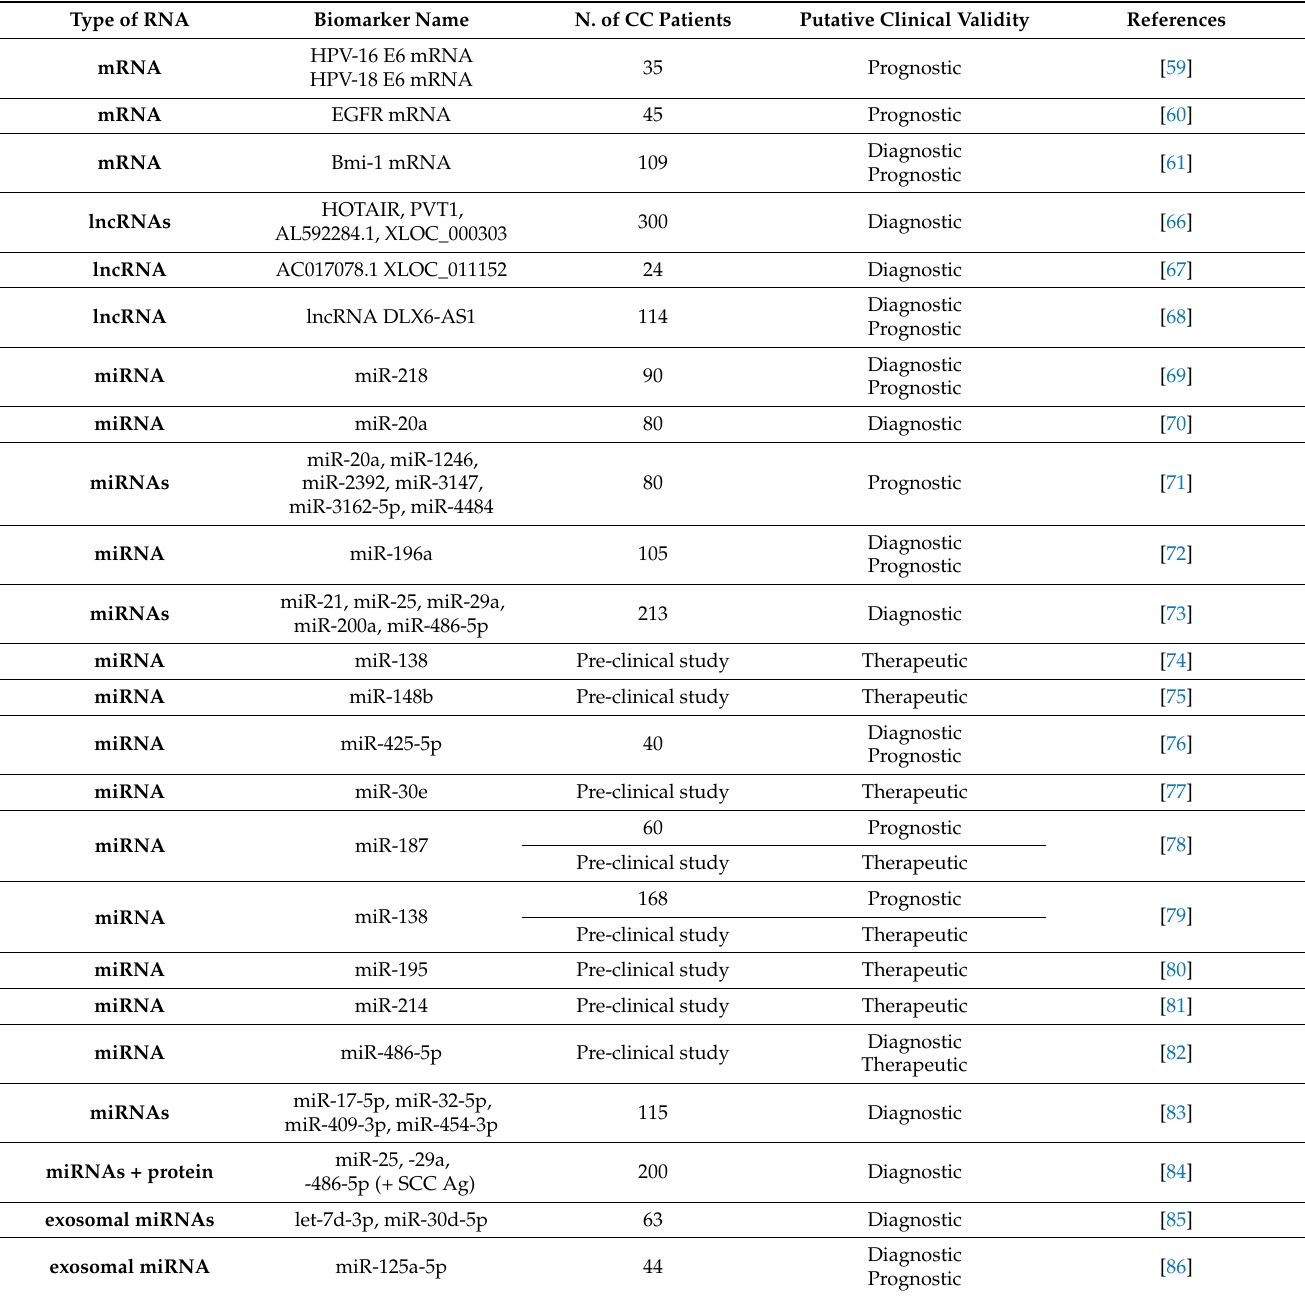
Table 3. Pre-clinical and clinical studies investigating the role of circulating RNAs in